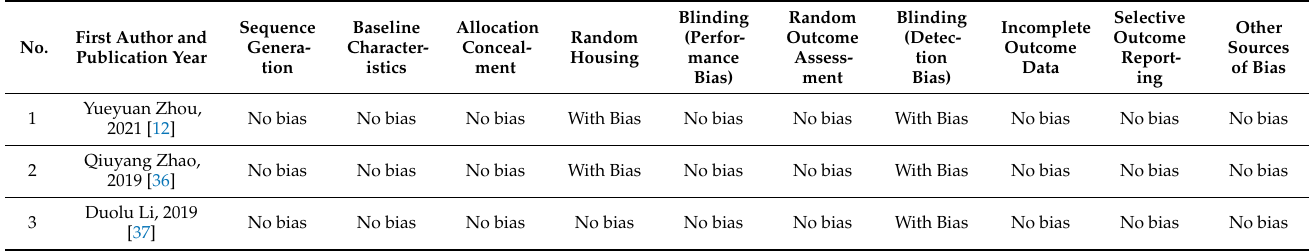
Table 4. Evaluating the potential bias among in vivo studies.